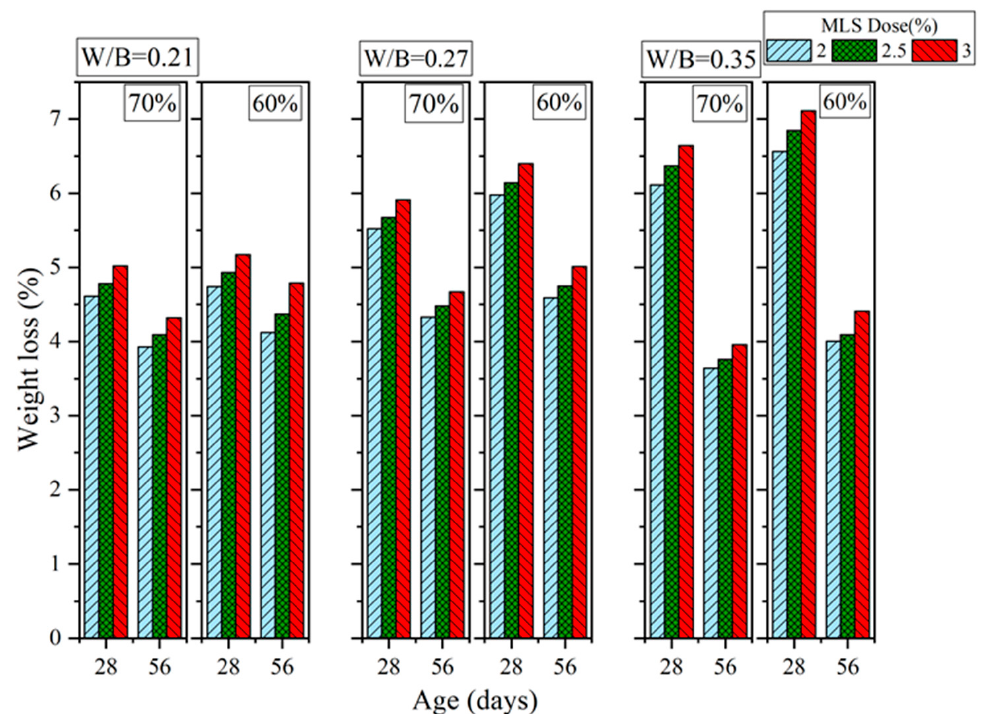
Figure 18. Sulfate resistance of green and ecofriendly grouting material with MLS.